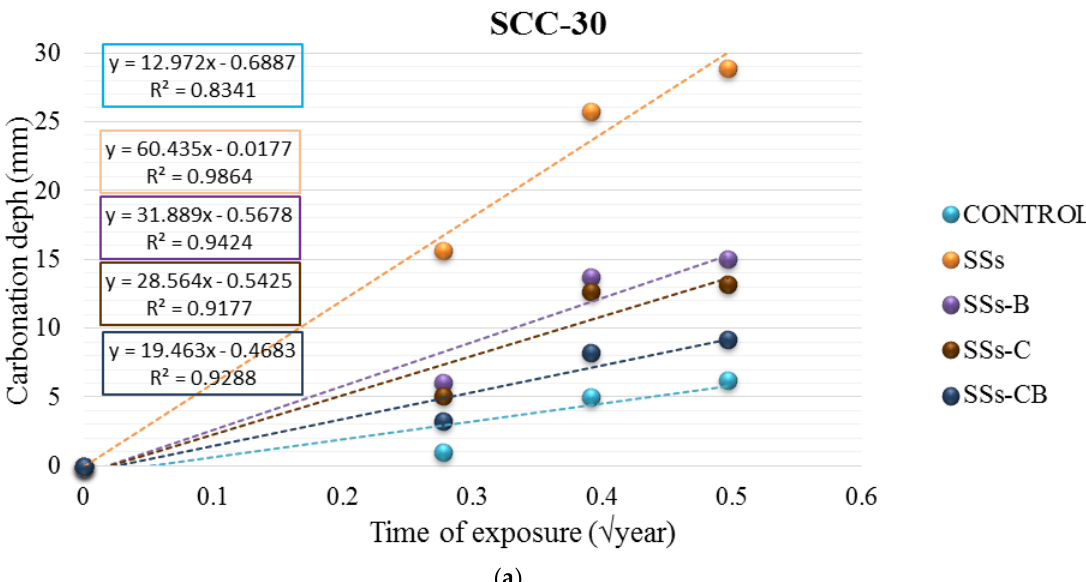
Figure 11. Carbonated SCC probes.